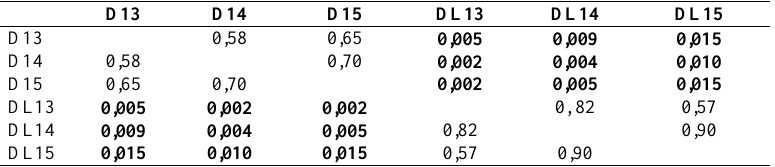
Table 3. The significant of differences for indicator "Share of enterprises engaged in technological innovation" by rank Kruskal-Wallis test